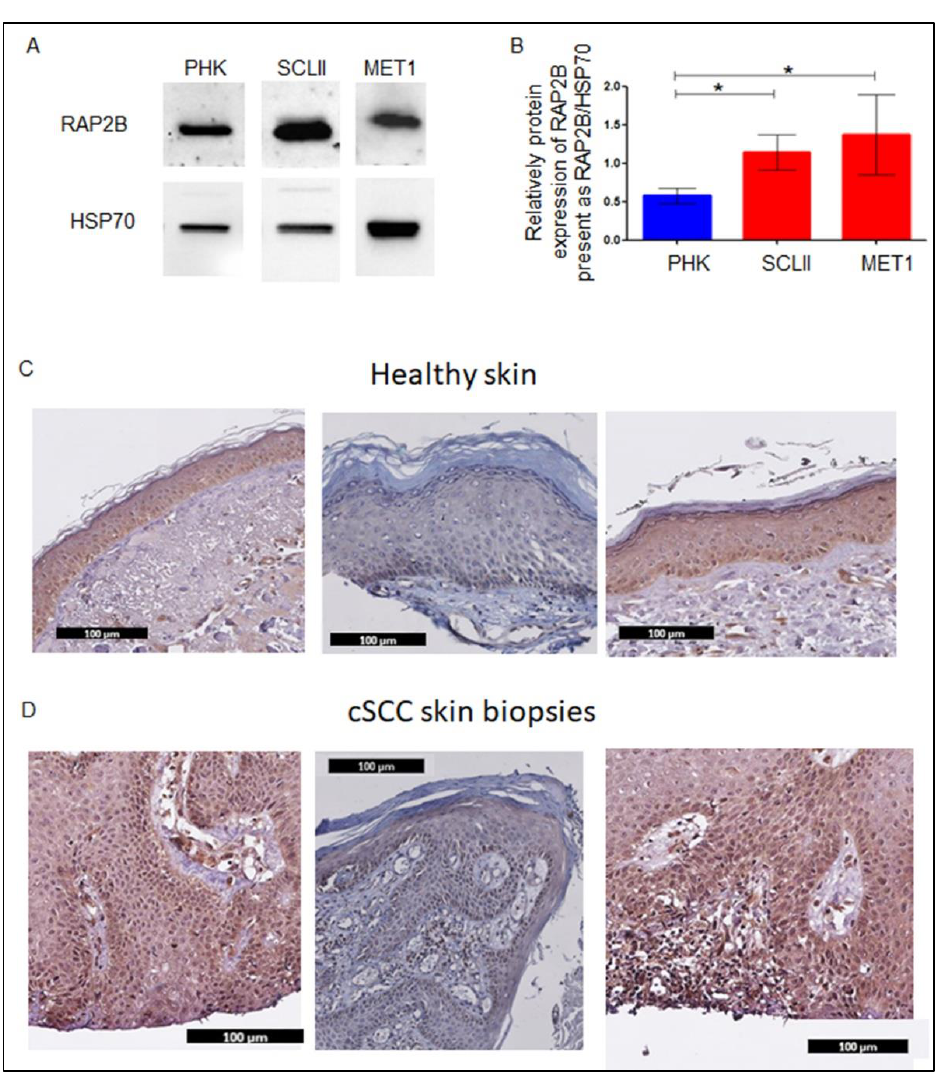
Figure 6. Expression of RAP2B in CSCC cells and CSCC biopsies. ( A ) WB analysis of RAP2B in MET1, SCL-II, and PHK cells, and respective densitometry ( B ). The plot presents 3 independent measurements of WB experiments and shows the relative expression of RAP2B to HSP70. Statistics were performed using t-tests * p < 0.05. FFPE biopsy slides with mounted normal skin ( C ) and CSCC ( D ) were immune stained with anti-RAP2B antibodies. Antibody binding was visualized with DAB (3,3 (cid:48) -Diaminobenzidine) which yields an insoluble brown